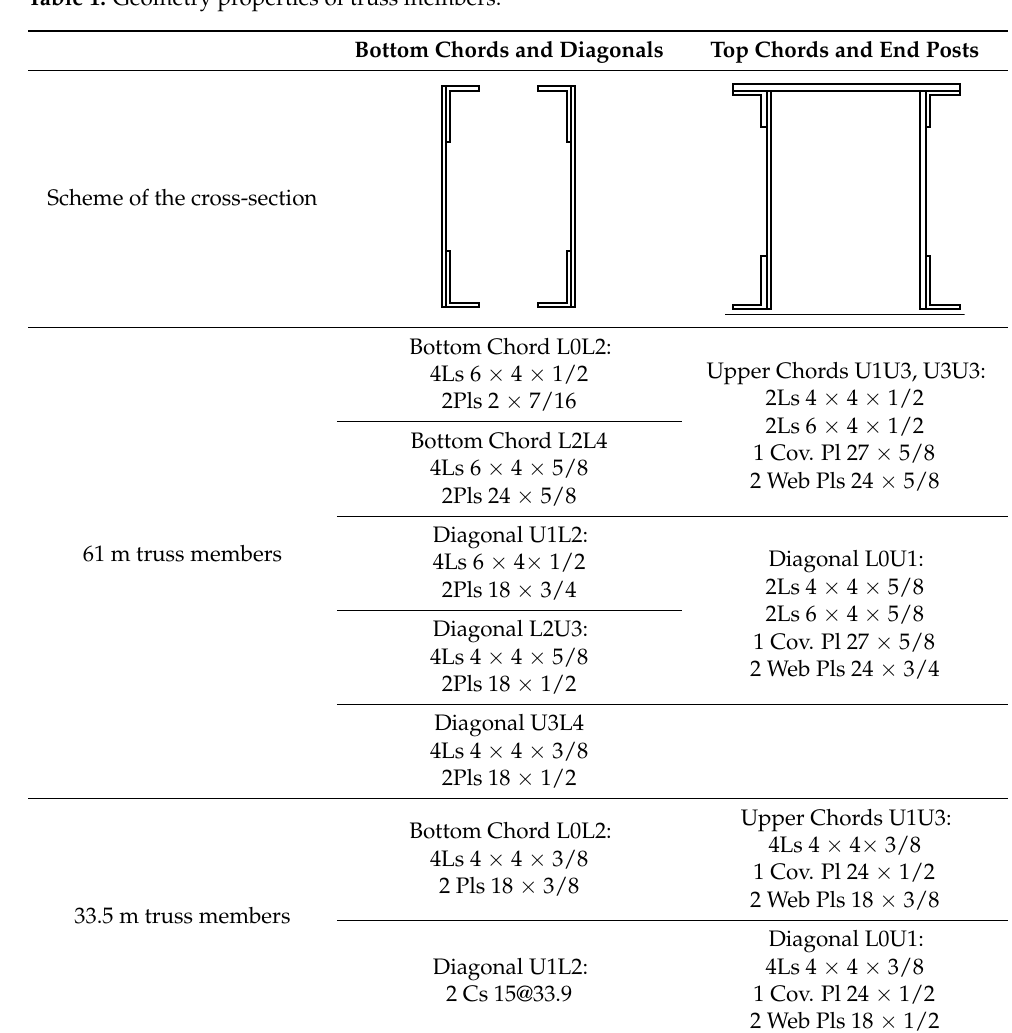
Figure 4. Investigated deck plate girder (DPG) bridge dimensions and strain gauge locations (1 ft = 0.305 m).